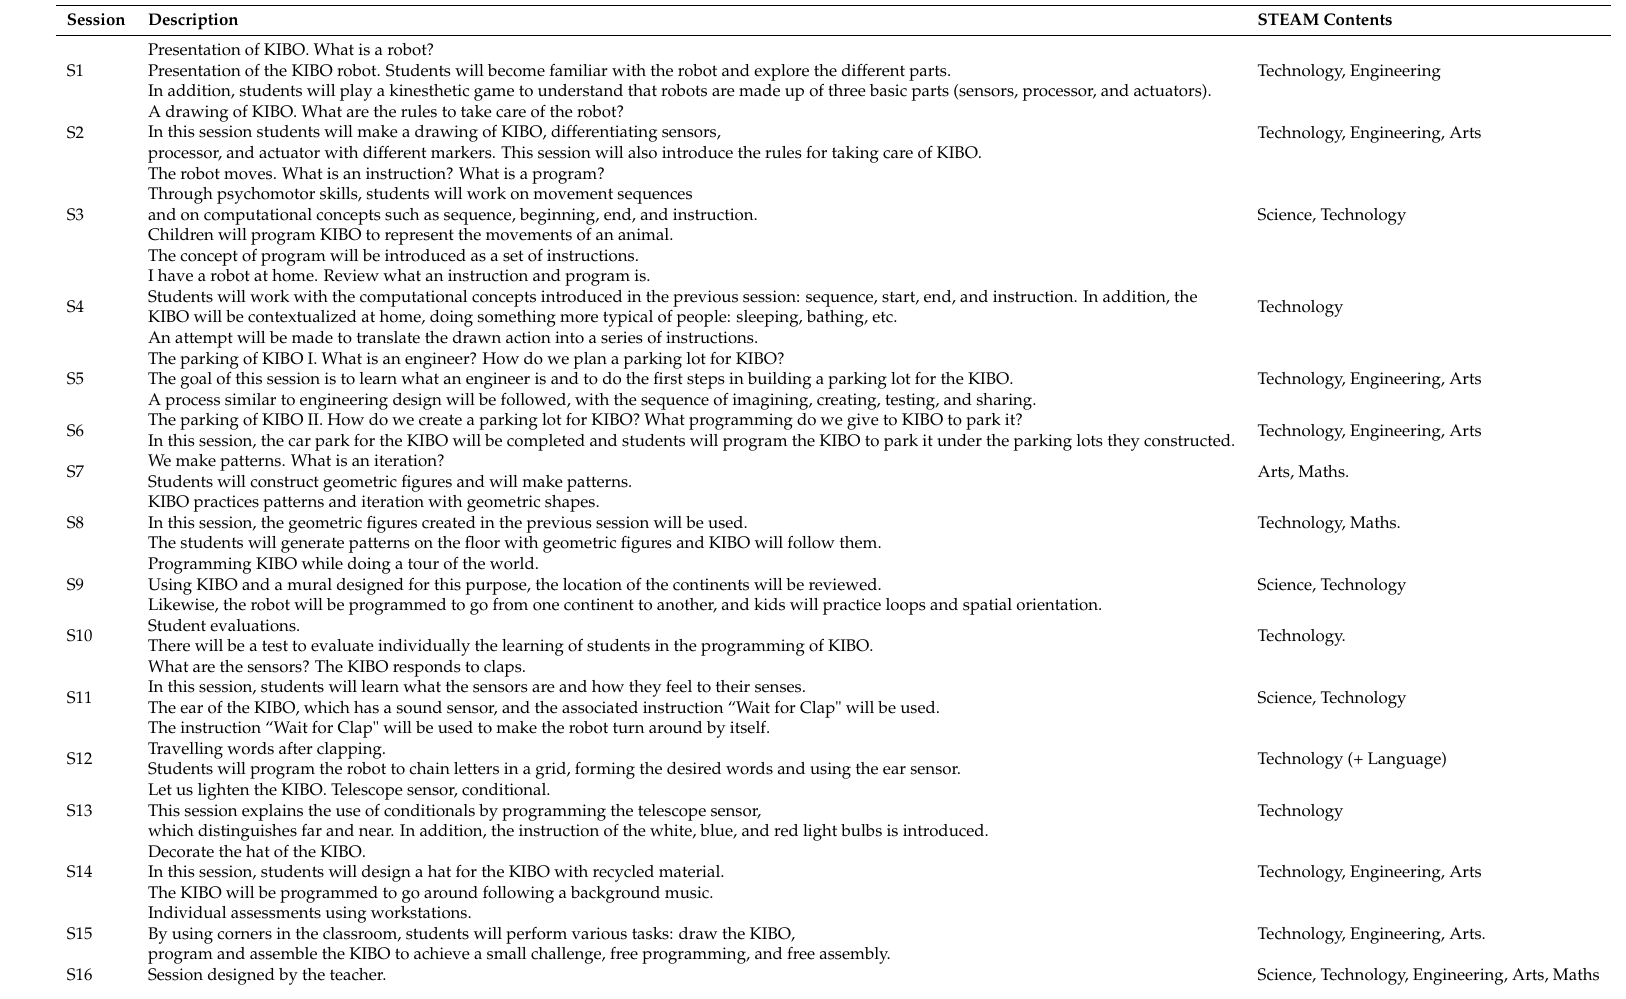
Table 1. Sessions of the developed curriculum: It also indicates the Science, Technology, Engineering, Arts, and Mathematics (STEAM) contents treated during the